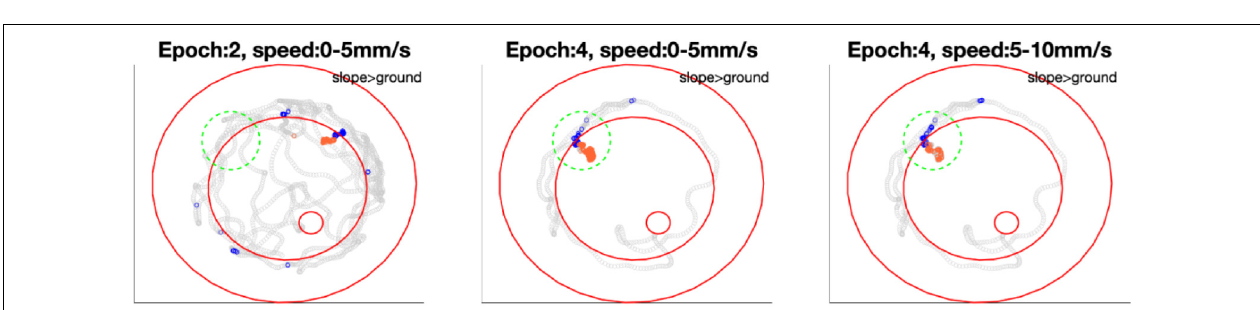
FIGURE 8 | Differences in neuro-activity between slope and ground at a certain speed were not constant over time. The example shown here stems from Bee 140409, unit 1. Other examples are shown in Supplementary Figure S5 . The whole recording time was cut into 5-min epochs. (A) Neuro-activity along time (abscissa) when the bee was on the slope walked at different speed (ordinate). Spike activity is expressed in false color as indicated in the right upper corner. (B) The same graph for the bee walking on the ground. (C) Comparison of time dependence of spike activity between slope and ground. Higher spike activity on the slope is expressed in yellow, and higher spike activity on the ground in blue. * marks significant differences between slope and ground ( p < 0.05 in independent-samples t -tests after Bonferroni correction). × marks low sample numbers ( < 30) that lead to less reliable statistic results and are thus excluded from our statistics.